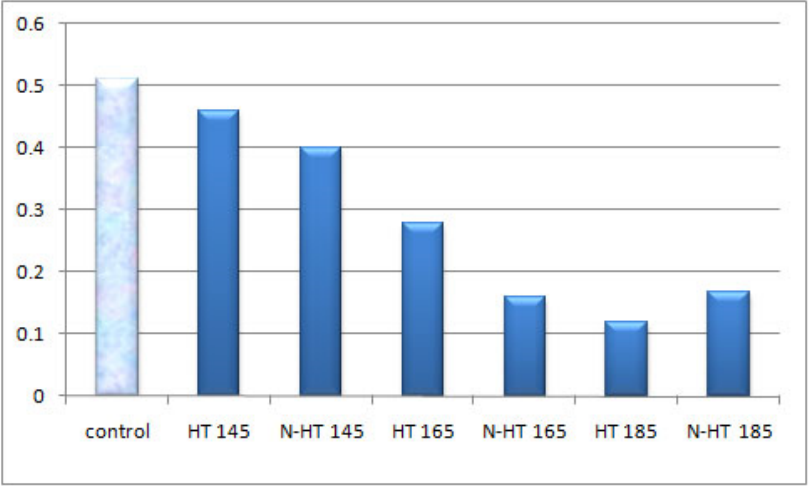
Figure 6. Crystallinity in control along with six heat ‐ treated pine specimens (HT = heat ‐ treated at a determined temperature; N = nano ‐ silver impregnated).